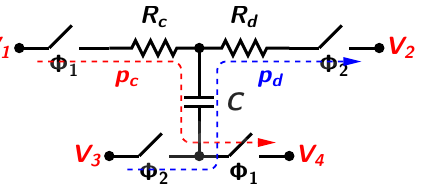
Figure A2. Analysis of single-stage DCP with non-symmetric charging and discharging schemes.